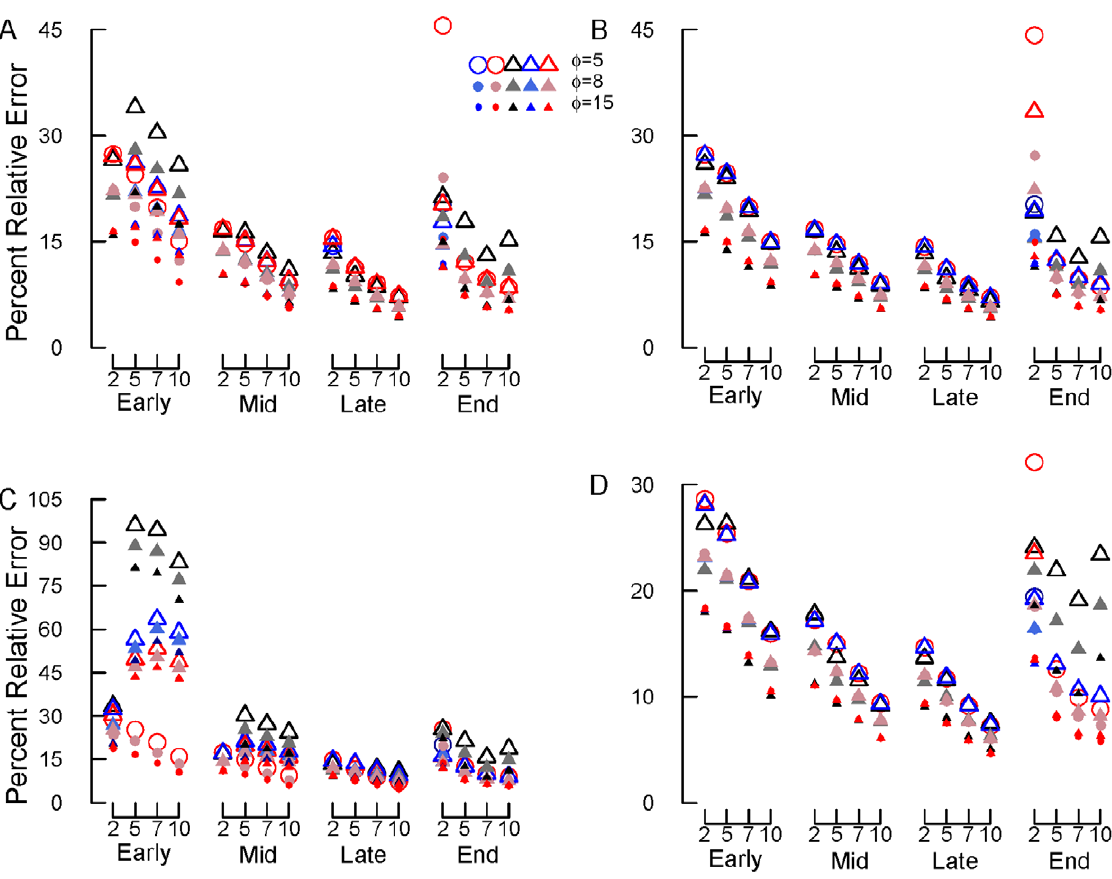
Figure 5. Percent relative error for beta-distributed errors plus normal errors with different s and transformations. (A) s =0.0125 (option 3a) and SV transformation, (B) s =0.0125 (option 3a) and REP transformation, (C) s =0.05 (option 3b) and SV transformation, (D) s =0.05 (option 3b) and REP transformation. Early, mid, late and end are early, mid, late and end stage decomposition simulations. The numbers 2, 5, 7 and 10 are the numbers of measurements used in each simulation. Blue circles=NLS, Red circles=Normal ML, gray/black circles=Beta ML. In most cases, nls=Normal ML so that the red circles cover the blue circles.